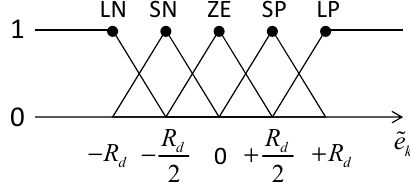
Figure 5. Membership function of defuzzifier (fuzzy set B).